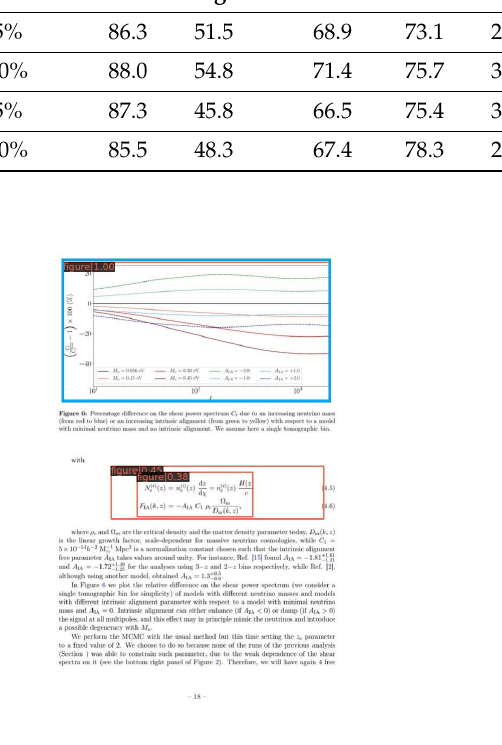
Figure 12. The results of out model equipped with Faster R-CNN and ResNet101 and trained on 5% of sub-PubLayNet labeled data. Blue represents True Positives and Red represents False Positives. In this figure, ( left ) represents a sub-DocBank sample with a True Positive and False Positives, ( right ) shows True Positives and False Positives on a sub-IIIT-AR-13K